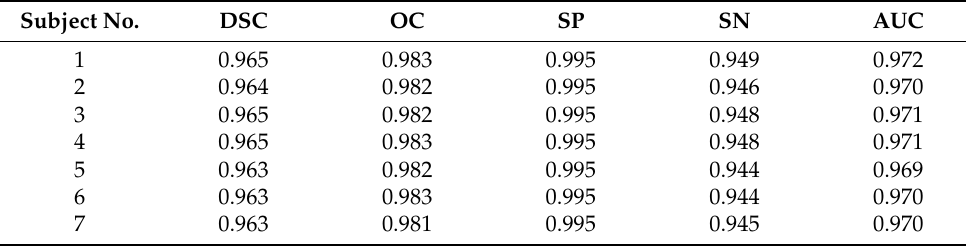
Table A9. Evaluation results for whole cerebellum segmentation, without fissures (model M3) on BrainWeb